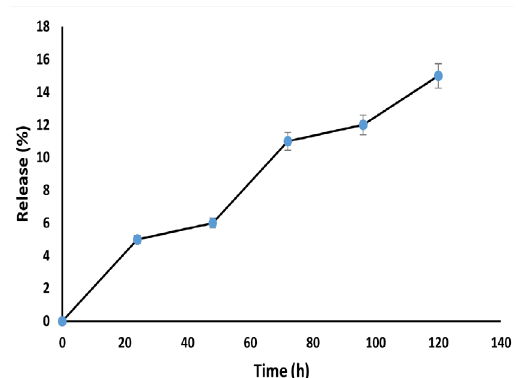
Fig. 3. Weight loss (%) of chitosan and chitosan-antibacterial Fig. 4. Release rate (%) of antioxidant-antibacterial fraction in nanoparticles during 5 weeks PBS at 37°C under continuously shaking for 120h incubation.